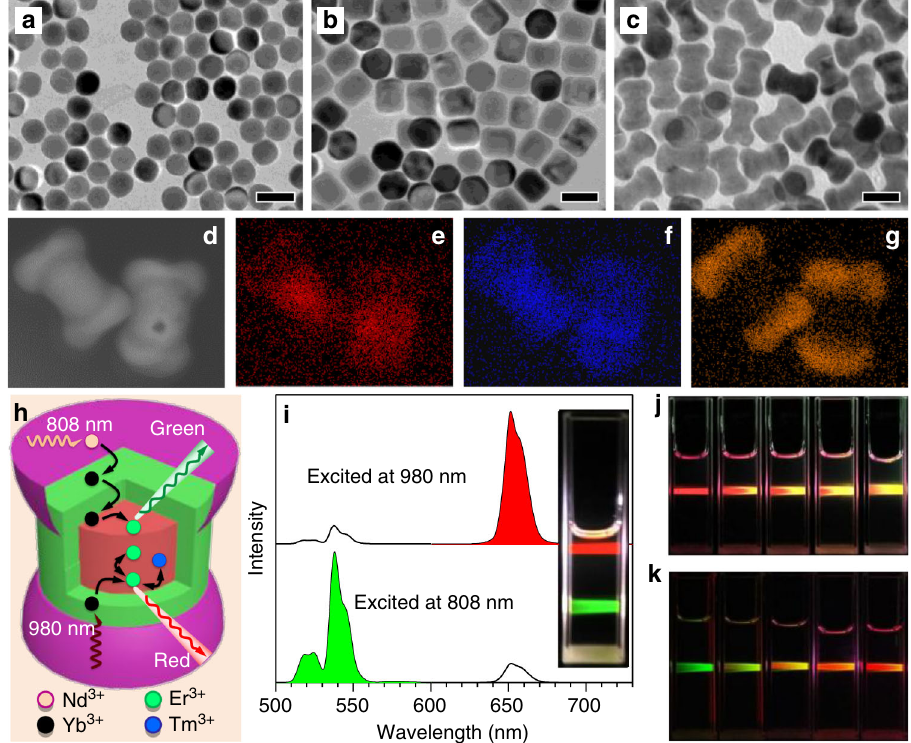
Fig. 1 Tm 3 + doped orthogonal emission UCNPs. a – c TEM images of the Tm 3 + doped core, core@shell and the dumbbell shaped NPs. Scale bars are 50 nm. d – g HAADF image and corresponding elemental mapping of Er 3 + , Yb 3 + , and Nd 3 + ions. h Energy migration process of the Tm 3 + doped UCNPs when irradiated with 980 nm or 808 nm NIR lasers. i Upconversion luminescence spectra of the nanocrystals under excitation with a 980 nm or 808 nm continuous-wave lasers. Inset image is the corresponding photo showing red and green emission colors upon NIR excitation. j Photos of the Tm 3 + doped UCNPs in cyclohexane when excited at a fi xed 980 nm laser power (1 W) with increasing 808 nm laser power from 0 W to 3 W. k Photos of the Tm 3 + doped UCNPs in cyclohexane when excited at a fi xed 808 nm laser power (2 W), while increasing the 980 nm laser power from 0 W to 2.5